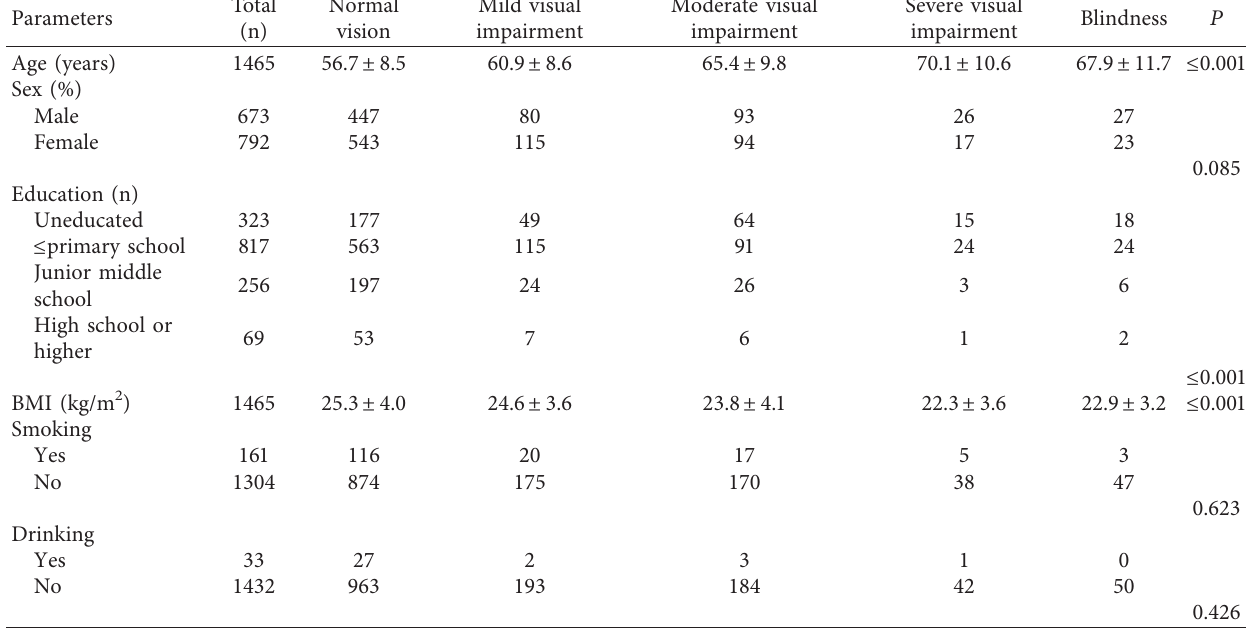
Table 1: Demographic characteristics of the participants with different visual impairment levels.